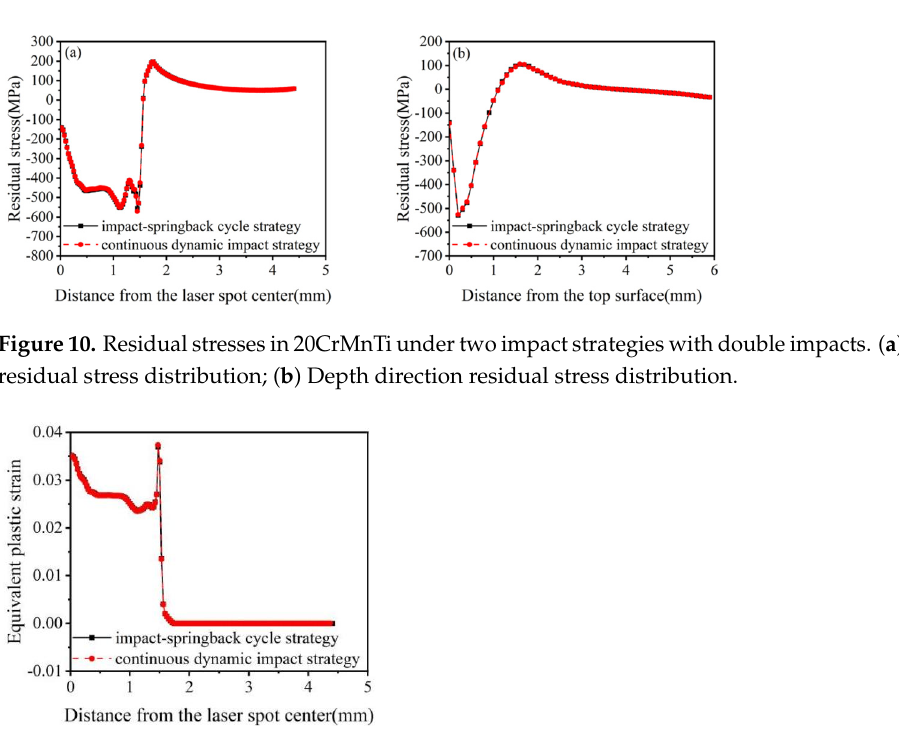
Figure 11. Equivalent plastic strain of 20CrMnTi under two impact strategies with double impacts.